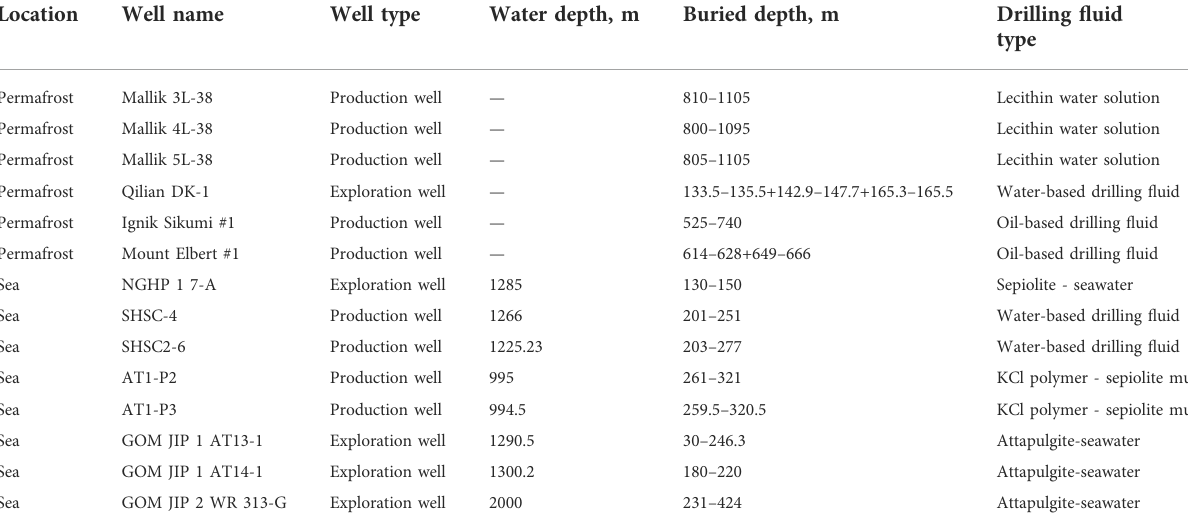
TABLE 3 Gas hydrate drilling fl uid system (Burger et al., 2006; Collett et al., 2015; Merey, 2016; Merey, 2019; Wu et al.,